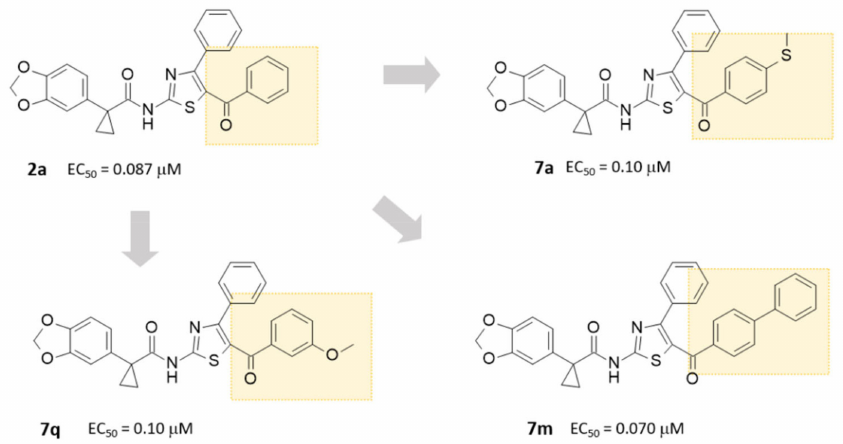
Figure 1. Chemical structure and biological activity of the previously developed hybrids as F508del CFTR correctors. Compound 2a is represented as prototype of the first hybrids series while congeners 7 are reported as representative of the second one. Some of the most effective substitutions involving the thiazole position 5 are highlighted in light